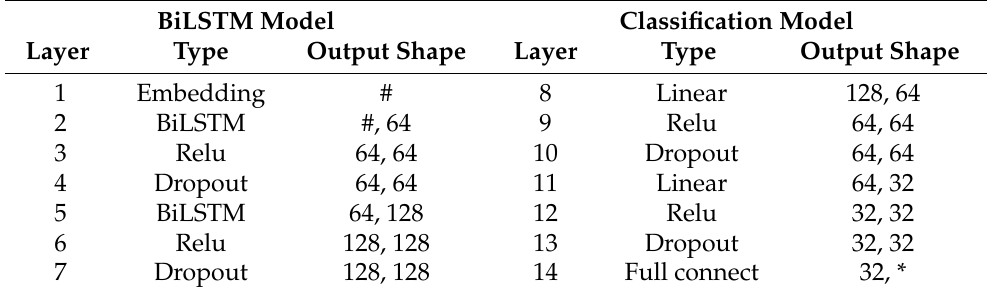
Table 3. Hyperparameter